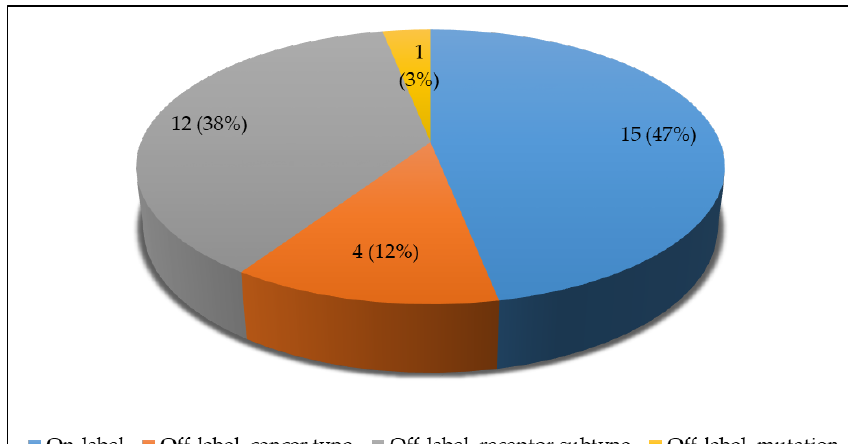
Figure 4. A total of 32 NGS-based therapies were recommended to 30 patients. Of the 17 off-label